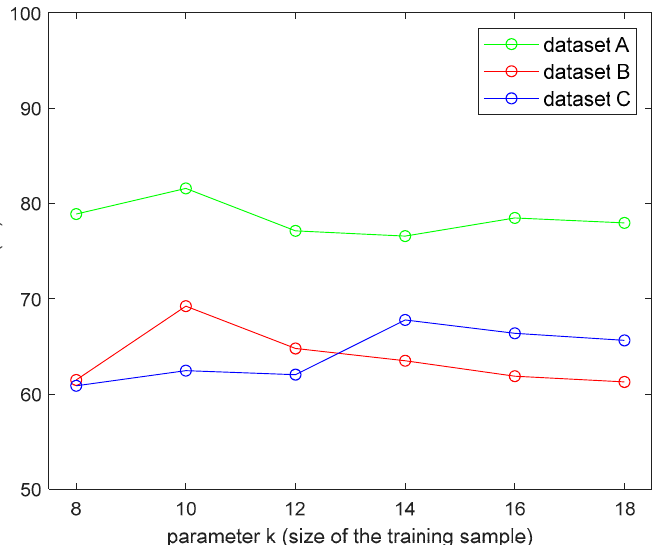
Figure 7. Relationship between OA and the size of the training sample on three real SAR datasets.